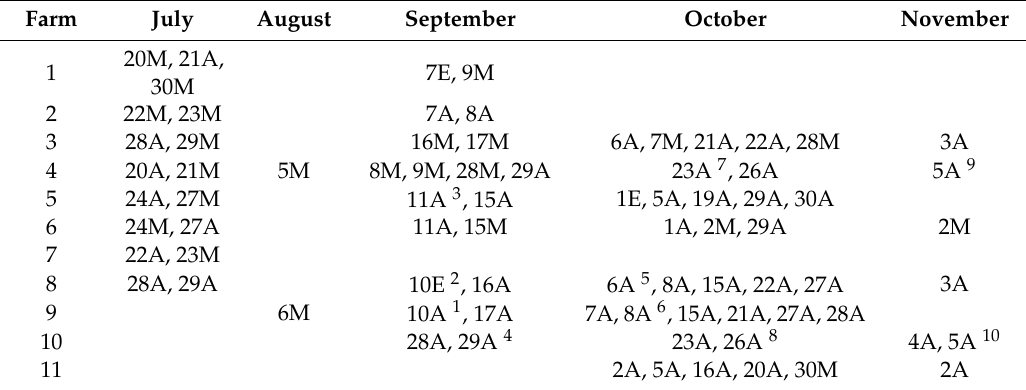
Table 2. Date and start times * (M(orning); A(fternoon); E(vening)) of 90-minutes observation periods (n = 79).